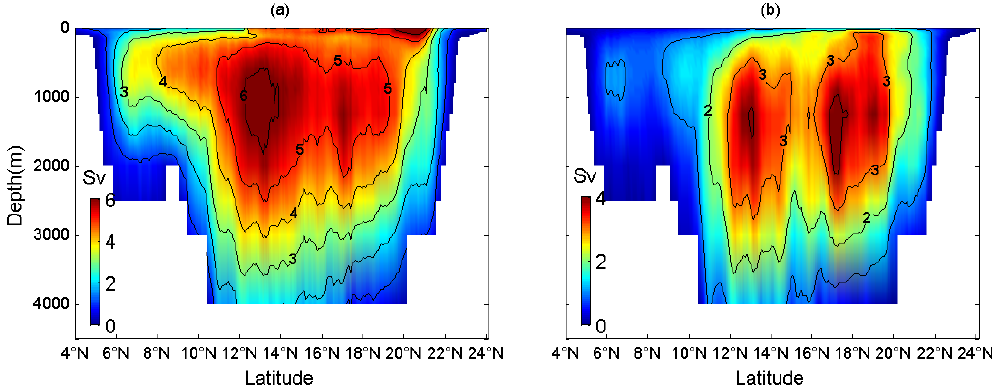
Figure 4. (a) The standard deviations of the SCSMOC in 2010 and (b) the filtered 1–3-day SCSMOC signal in 2010.